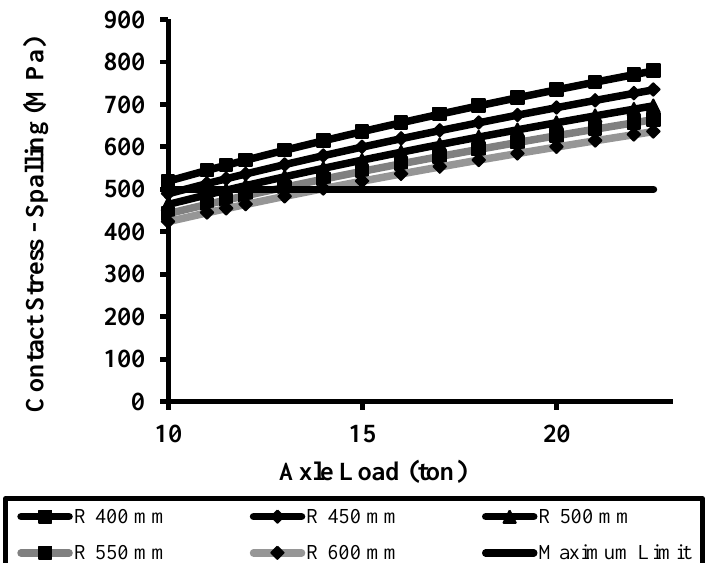
Fig. 3. Variations of contact stress spalling with axle load for different wheel radiuses.